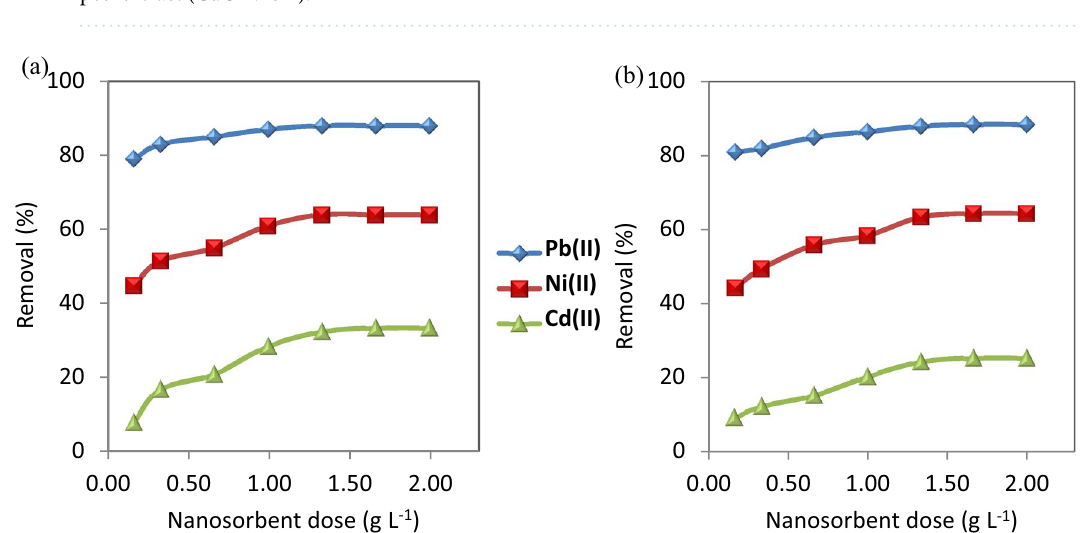
Figure 4. Effect of nanosorbent doses on the removal of the studied metal ions using ( a ) CuO NPs-1 and ( b ) CuO NPs-2 at initial concentration: 20 mg L −1 , pH: 6, and contact time: 60